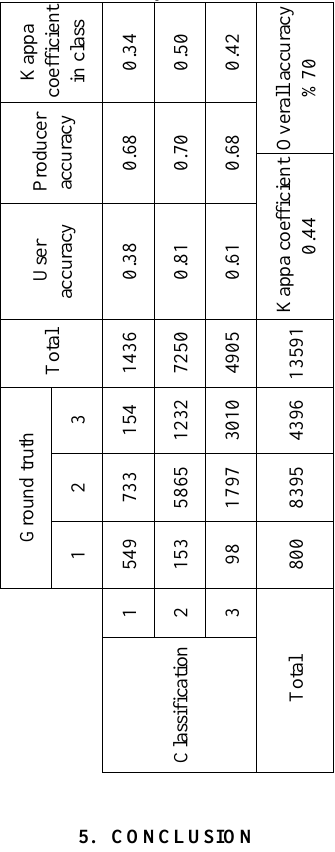
Table 1. Error matrix of the best classification with three density